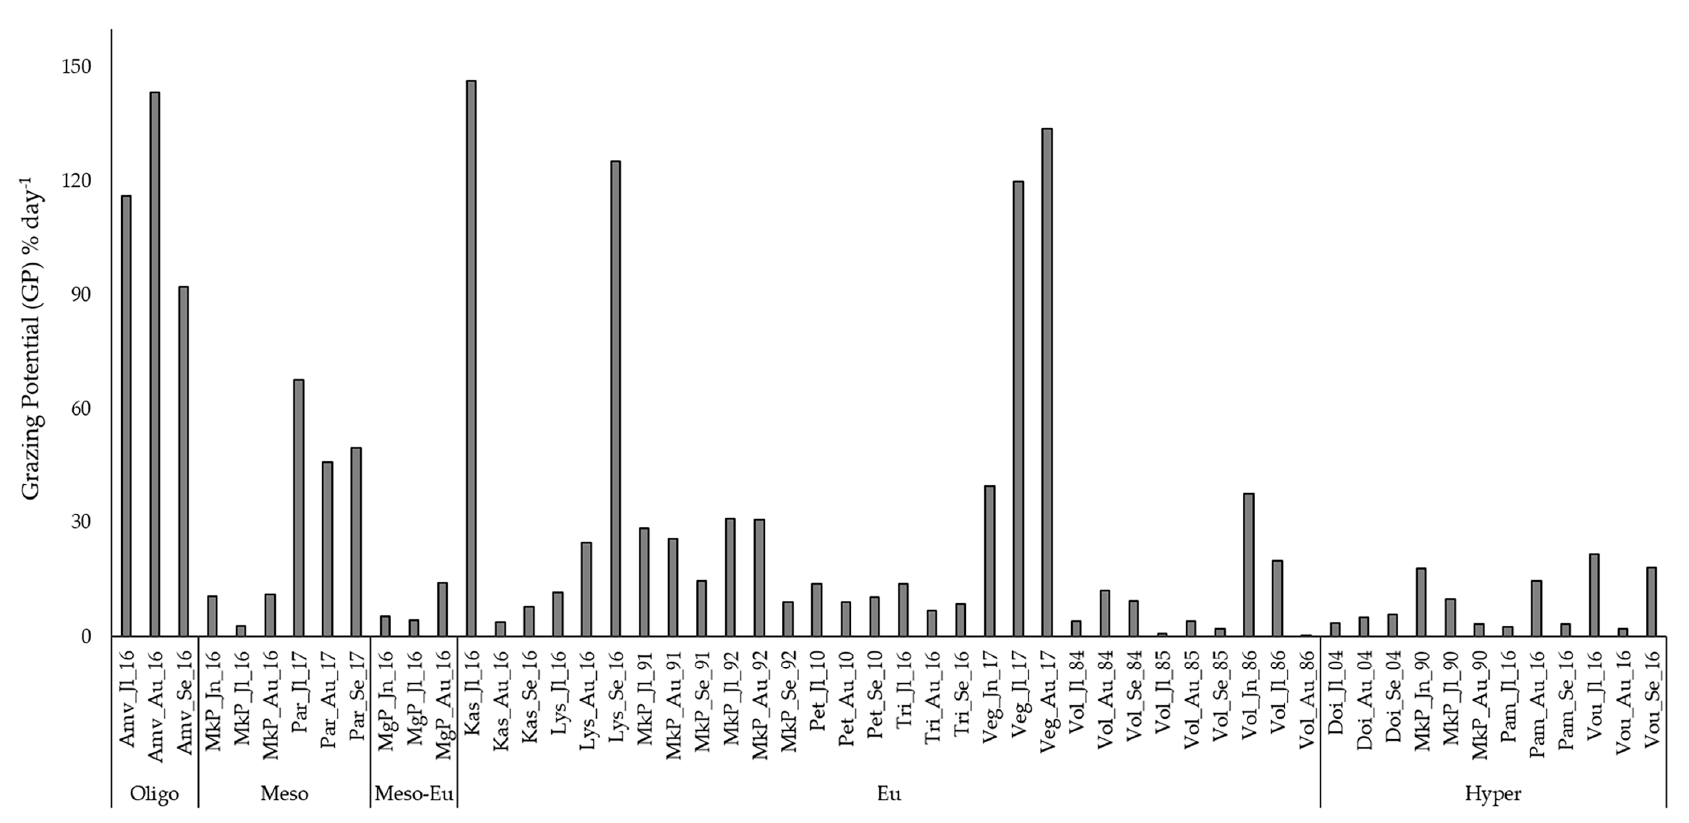
Figure 2. Grazing potential values of the studied lakes in the various dates (lake abbreviations according to Table 1 followed by month and year of sampling) across the trophic spectrum (Oligo: Oligotrophic, Meso: Mesotrophic, Meso-Eu: Meso-eutrophic, Eu: Eutrophic and Hyper: Hypertrophic).